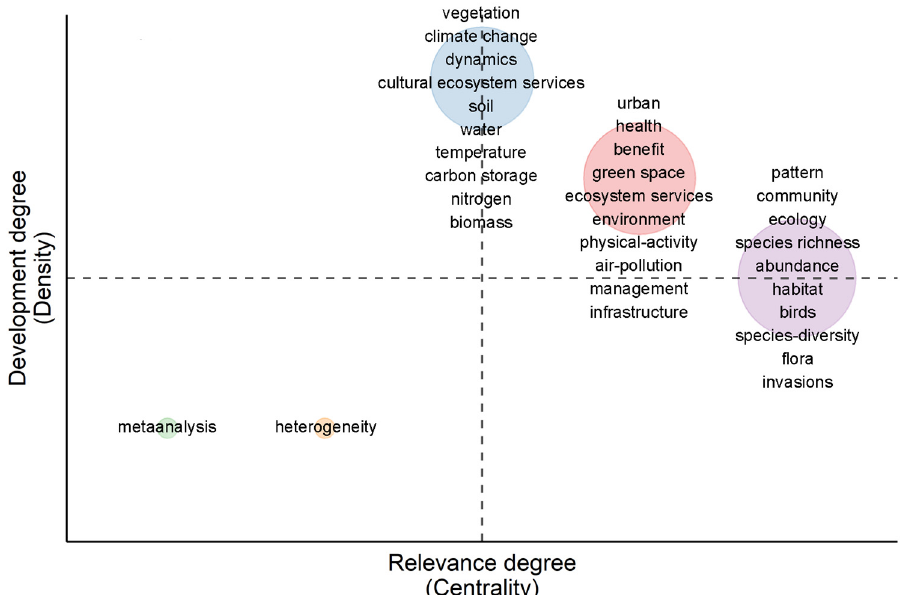
Figure 8. Thematic map. The horizontal axis is the centrality, which represents the relevance degree between a certain theme and other themes. It can be interpreted as the importance of this theme in the entire field development. The vertical axis is the density, which represents the development degree within a certain theme. It can be interpreted as the development status of the theme.